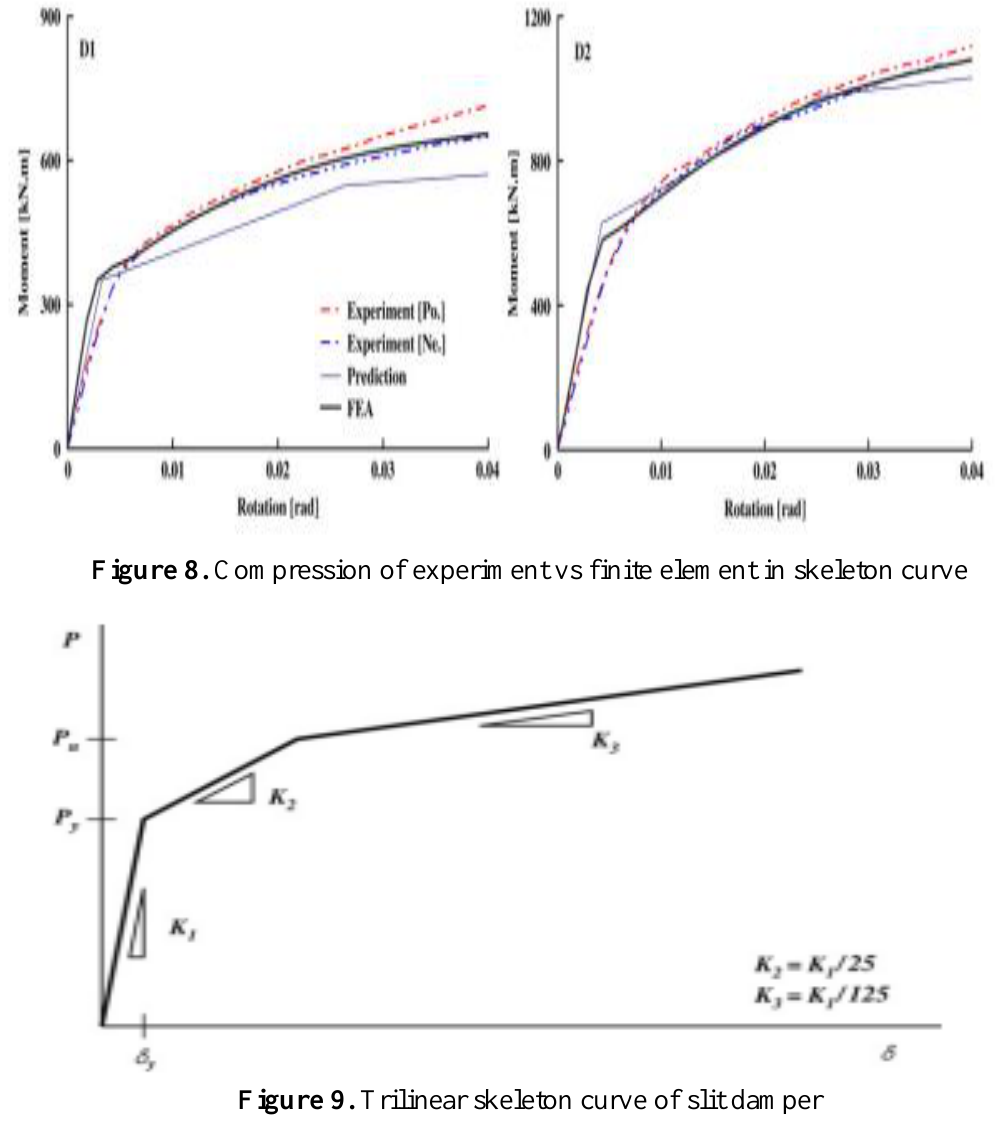
Figure 9. Trilinear skeleton curve of slit